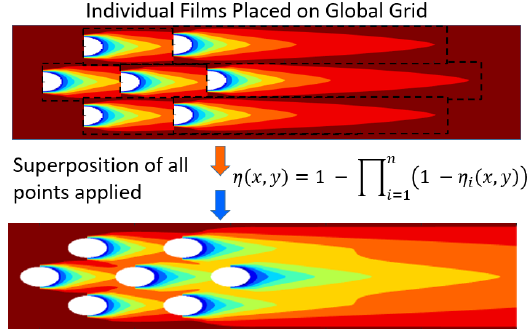
Figure 2. Visualisation of Sellers’ superposition